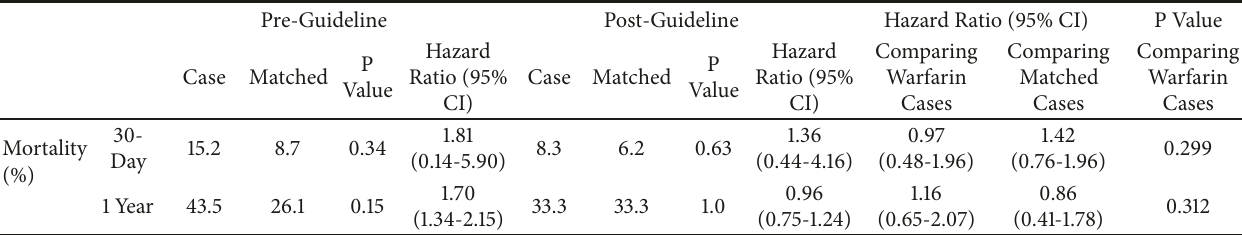
Table 5: A comparison of pre- and post-guidelinemortality % at 30 days and at 1 year for warfarinised patients and nonwarfarinised matched